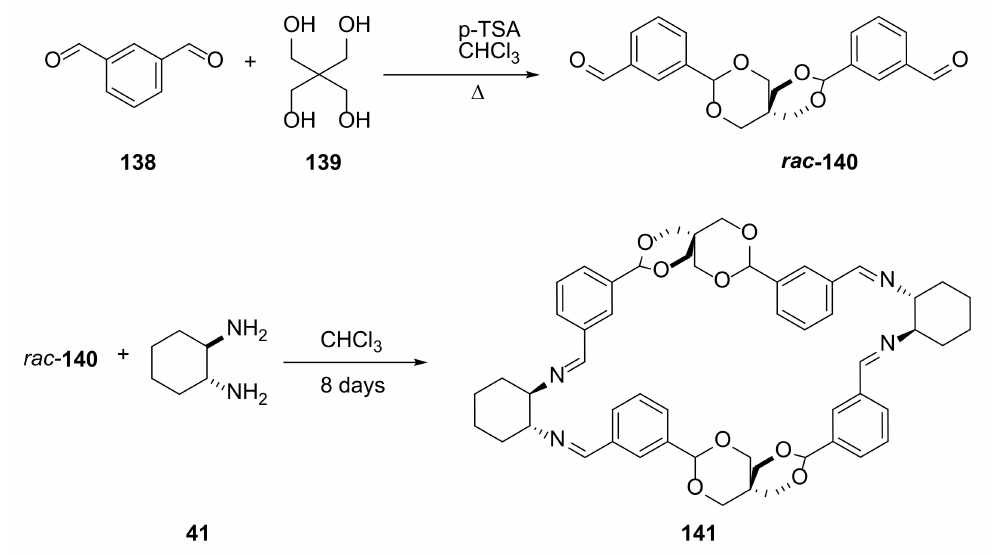
Figure 27. Mechanism of racemization of dialdehyde during macrocycle